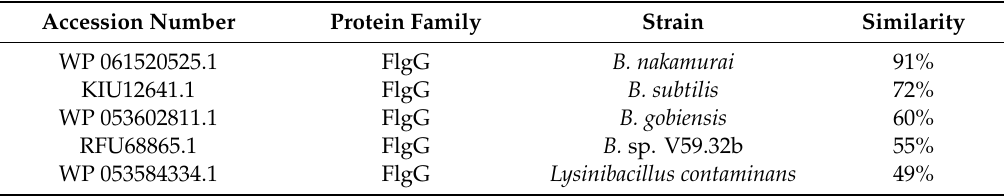
Table 1. Sequences with higher similarity to flagellin of B. velezensis UCMB 5033 (Accession number: CDG29557.1).